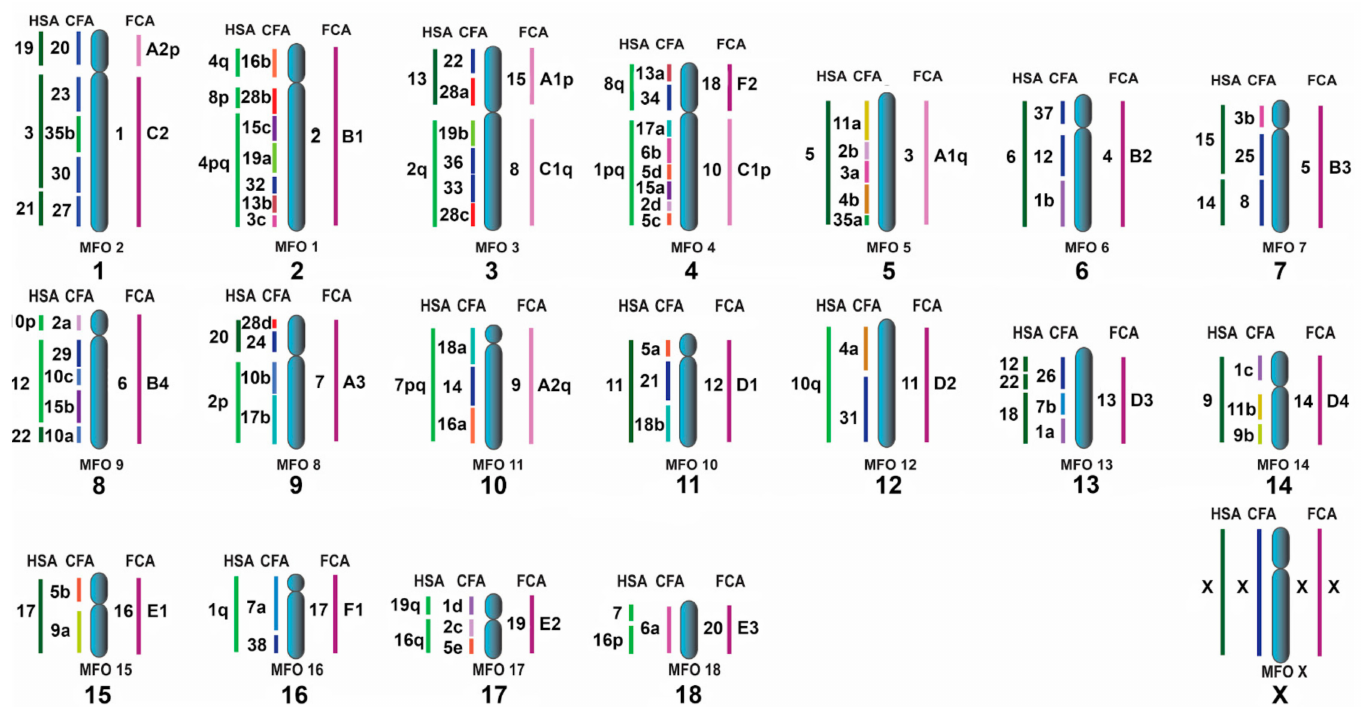
Figure 8. The ACK (2n = 38) updated according to [9]. Conserved and rearranged chromosomes in each species (FCA and HSA) are highlighted in di ff erent shades (dark and light). In CFA, the chromosomes represented by a single element in the ACK are shown in dark blue, whereas split chromosomes are each highlighted in a di ff erent color. To the right of the ancestral chromosomes is the number from the ACK 2n = 42 nomenclature [5]. All seven syntenic associations of human chromosomes shared by representatives of the Eutheria clade (HSA 3 / 21, 4 / 8p, 7 / 16p, 10p / 12pq / 22qt, 12qt / 22q, 14 / 15, and 16q / 19q) [5–7,37,67] were detected in pinniped species [8,9]. Our present work confirmed that one fission (HSA1), one inversion (HSA4q / 8p / 4pq), and five fusions (1q / 8p, 2q / 13, 2 / 20, 19p + 3 / 21, and 12qt / 22pq + 18) distinguish the ACK from the ancestral Eutherian karyotype